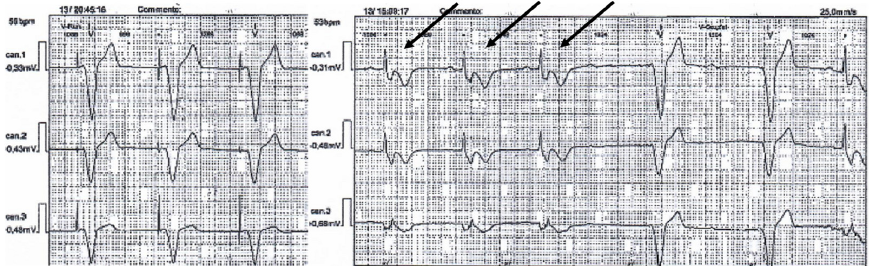
Figure 4. Proband’s dynamic ECG tracing showing PM rhythm with sporadic episodes of sponta- neous rhythm (arrows). Echocardiogram showed dilated hypokinetic cardiomyopathy, with reduced LVEF (35%). Respiratory function was normal.